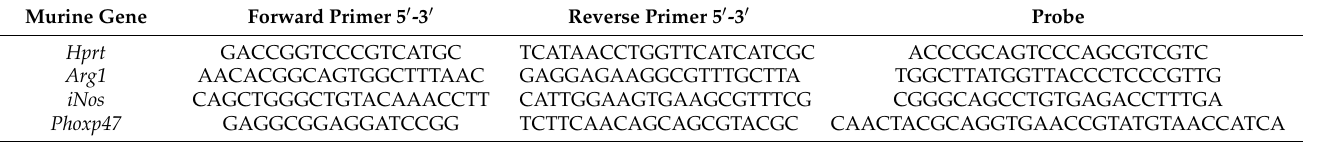
Table 1. Sequences of primers and TaqMan probes.